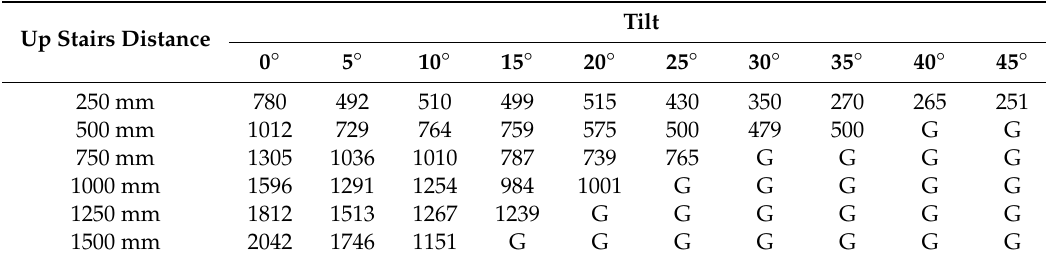
Table 5. Stairs going up detection results obtained for different distances and LIDAR tilt angles: (G) ground detected at its expected location, (numeric value) average distance in mm of the frontal obstacle detected.